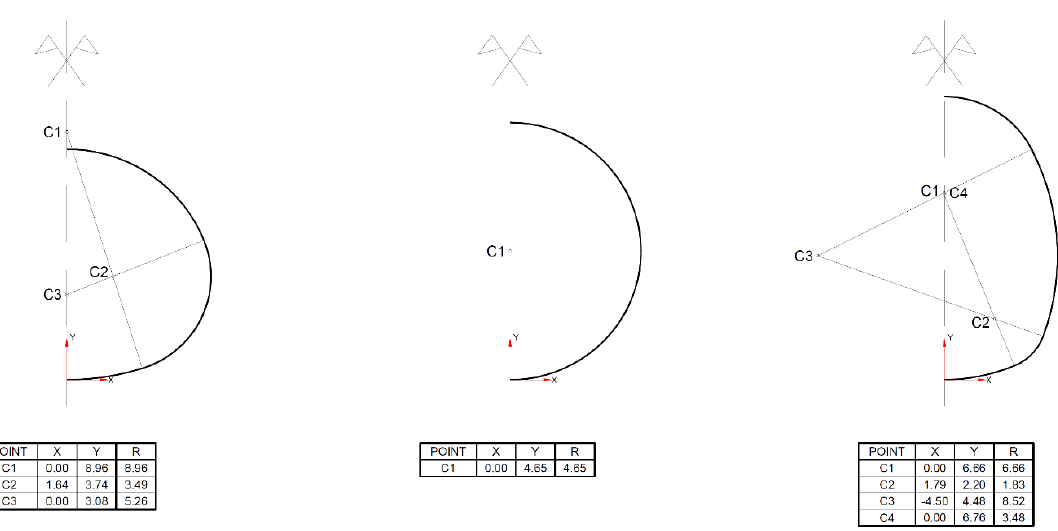
Figure 6. Tunnel geometries considered in the parametric